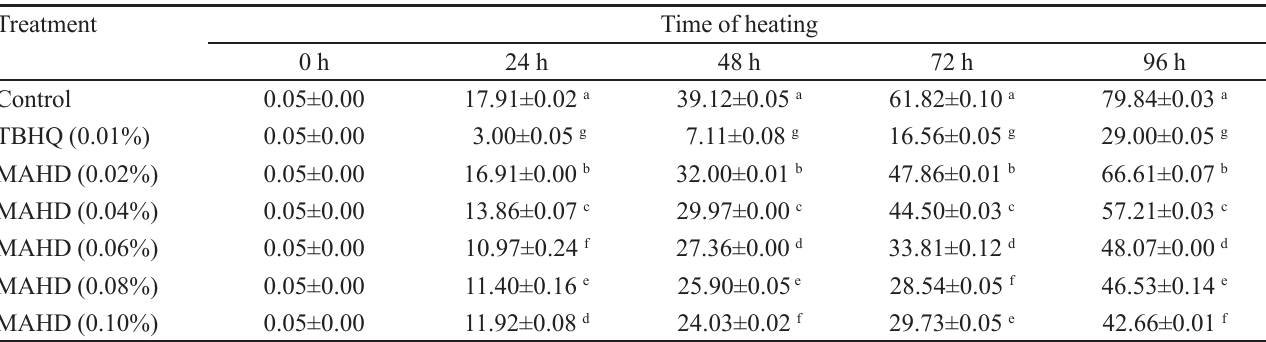
TABLE II - Peroxide values of sunflower seed oil with different concentrations of Heracleum persicum essential oil at 90ºC (meq/ kg